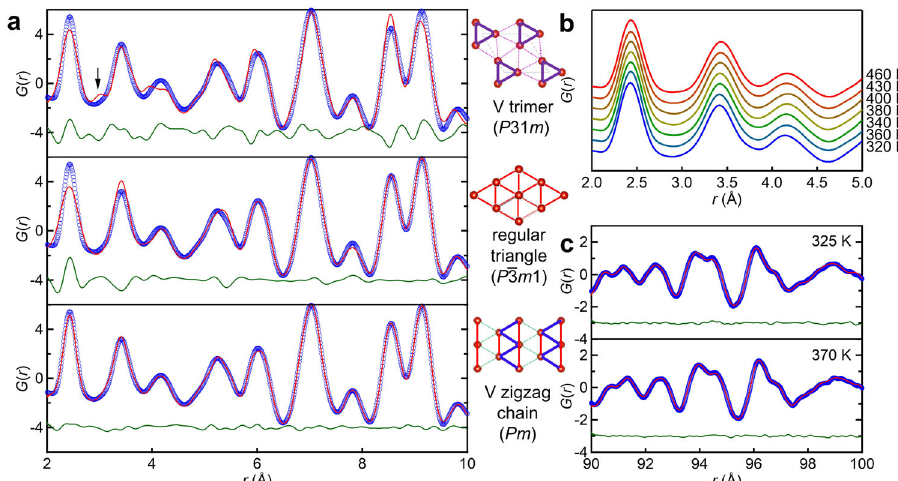
Fig. 2 Reduced pair distribution function (PDF) analysis of LiVS 2 in the high-temperature paramagnetic phase. a Fitting (red) and residual (green) for reduced PDF data (blue) obtained at 325 K. Average P 31 m model with V trimers (top) generates unrealized peak around 3.0 Å, resulting in a poor fi t. The P 3 m 1 model with regular triangular lattice cannot be fi tted well to the intensity data (middle). Best fi t is obtained by assuming the Pm structure with a zigzag chain (bottom). Adjacent V – V distances can be separated into three types, which are drawn in blue, red, and green in the Pm structure. Blue is the shortest and forms a zigzag chain. Initial structural model is obtained from the Rietveld re fi nement of the powder diffraction experiment at the corresponding temperature. b Temperature dependences of PDF data in the high- temperature paramagnetic phase. Increasing the temperature up to 460 K does not cause a remarkable change in the PDF patterns, indicating that the zigzag chain model can be applied up to at least 460 K. c PDF analysis in the range of 90 ≤ r (Å) ≤ 100 by assuming the Pm structure both for 325 K and 370 K data. The reliable factors are R w = 6.04% (325 K) and 5.29% (370 K),